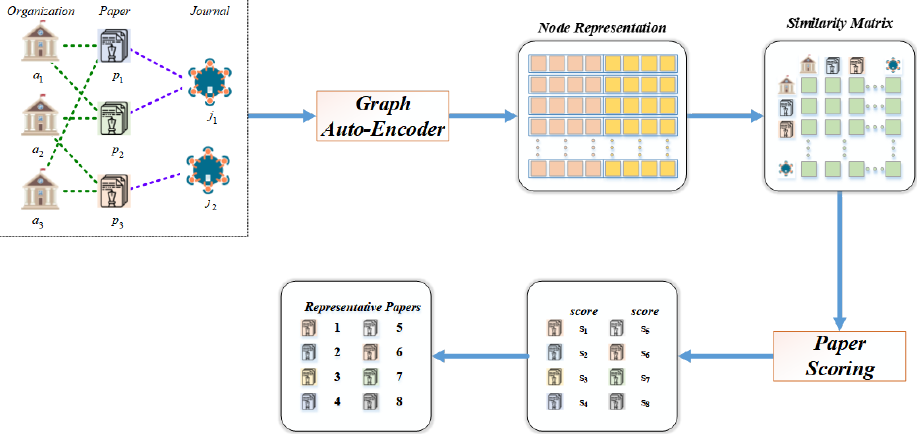
Figure 2. The proposed GAEPIM framework. GAEPIM consists of four steps. In the first step, GAEPIM constructs a paper–organization–journal heterogeneous network. In the second step, GAEPIM learns node representations using graph neural networks. In the third and fourth steps, all learned representations are injected into the similarity calculation to rank